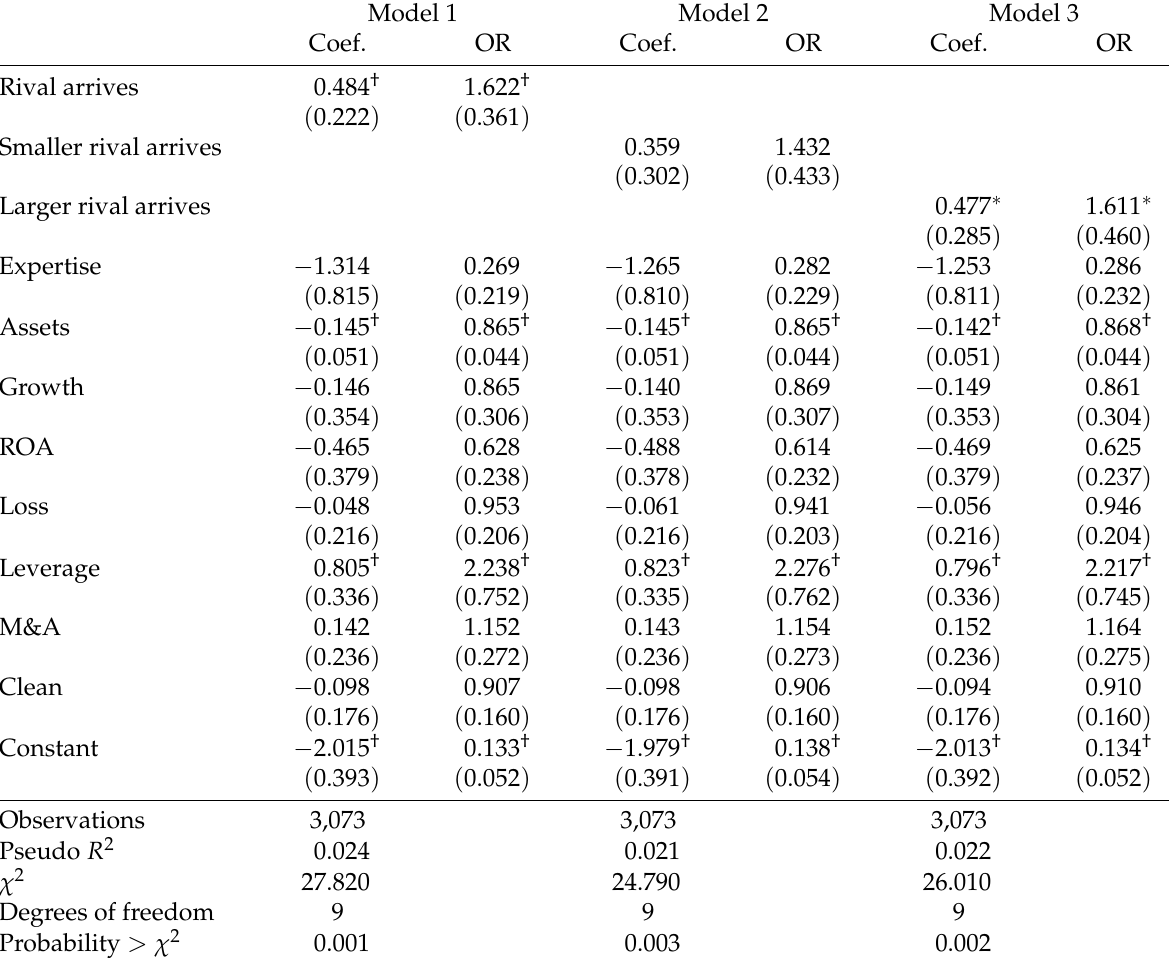
Table 6: Logit models to test for termination of auditor-client